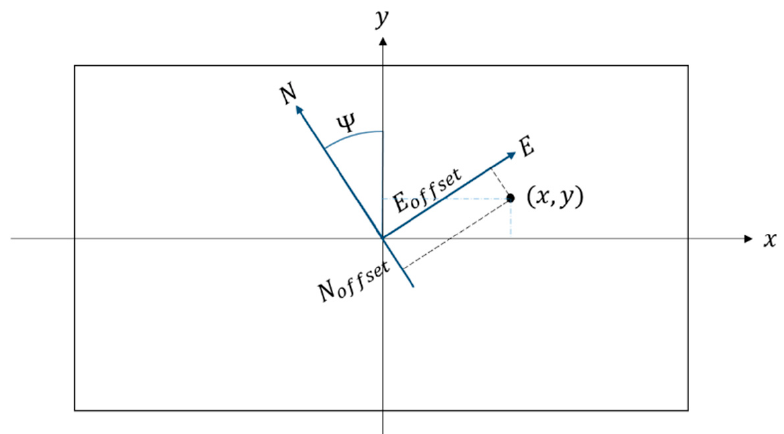
Figure 16. Coordinates of the camera and world frames.